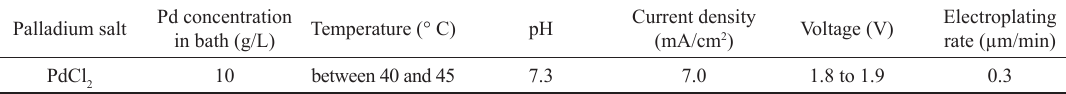
Table 3. Parameters used to Pd electroplate the surface of the Ni superalloy. Palladium salt